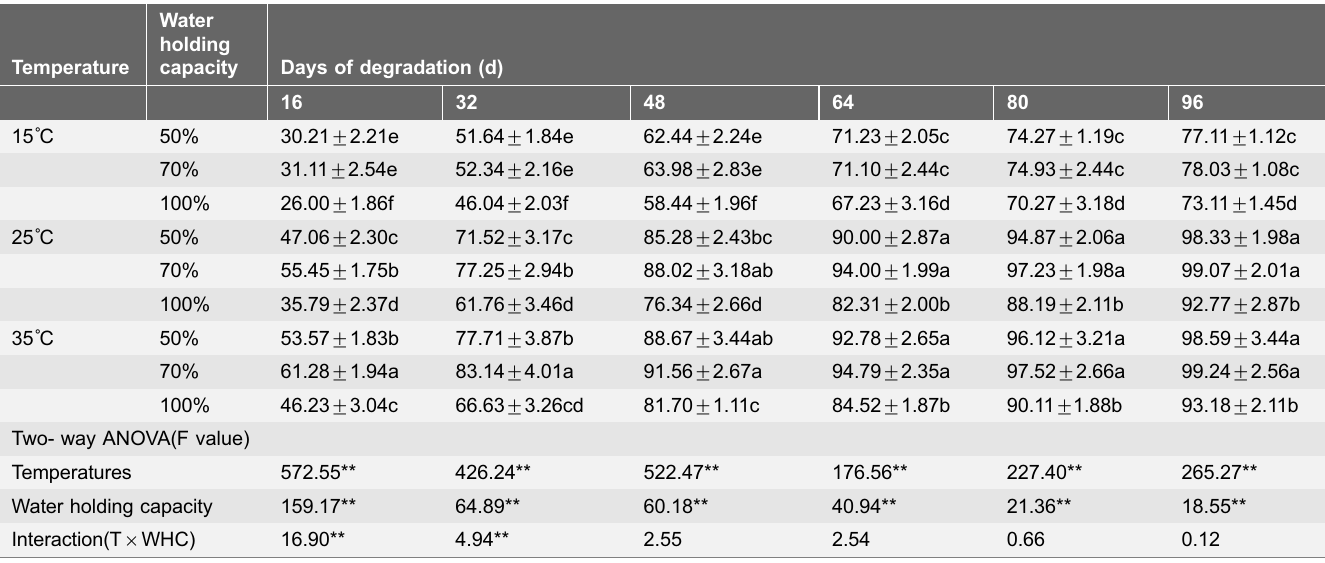
Table 1. The degradation rates (%) of Cry1Ac protein in leaves under different soil water content and temperature settings (data reported as the mean of three replicates ¡ standard deviation). Water holding Temperature